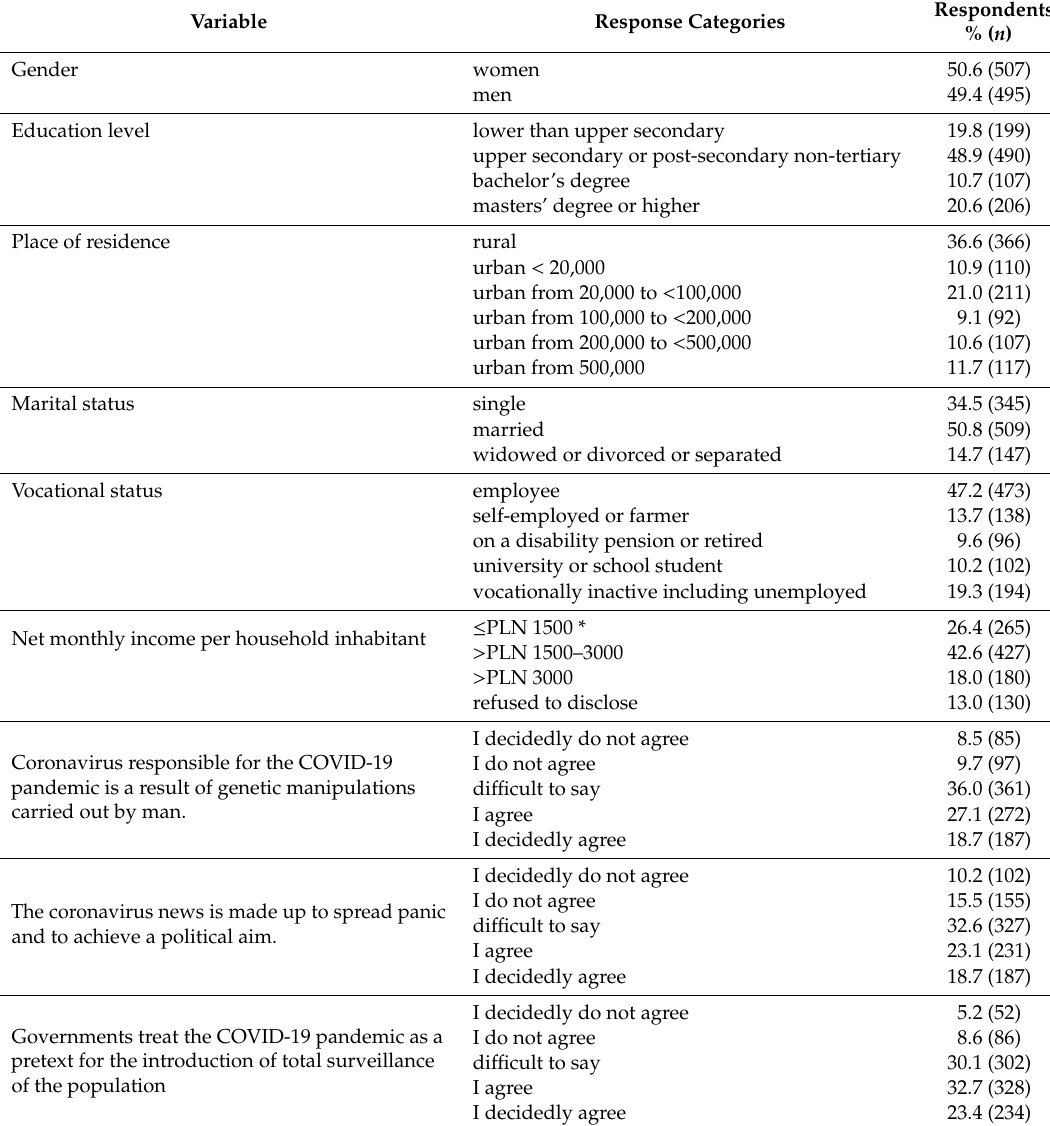
Table 1. Characteristics of the study